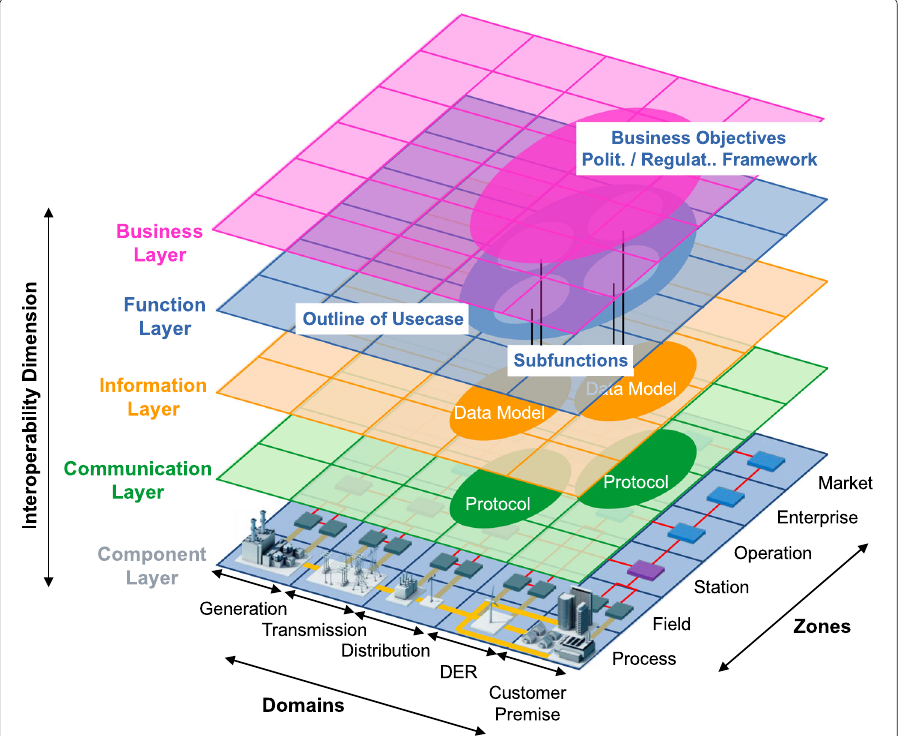
Fig. 2 Smart Grid Architecture Model (from CEN-CENELEC-ETSI Smart Grid Coordination Group